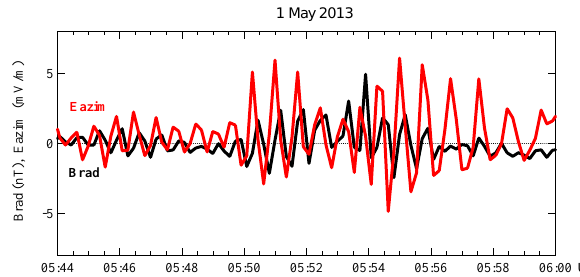
Figure 4. Van Allen Probe B observations of electric (red curve) and magnetic (black curve) fields from 05:44 to